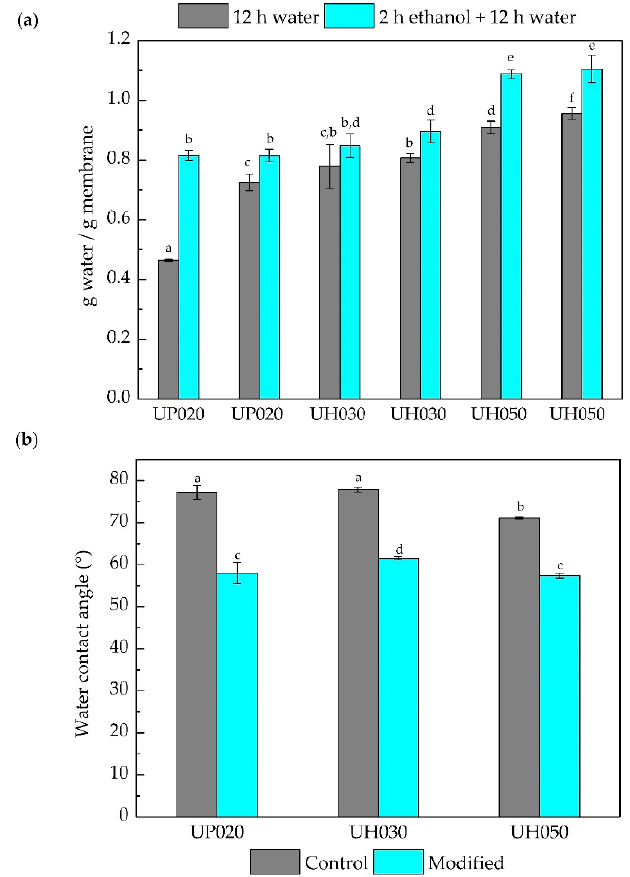
Figure 2. ( a ) Wettability of control and modified membranes measured after two di ff erent treatments. In the first bar, membranes were immersed in water for 12 h (treatment 1). In the second adjacent bar, the membranes were immersed in ethanol for 2 h and then immersed in water for 12 h (treatment 2). ( b ) Water contact angles for control and modified membranes. Bars with di ff erent letters show a statistical di ff erence ( p < 0.05).